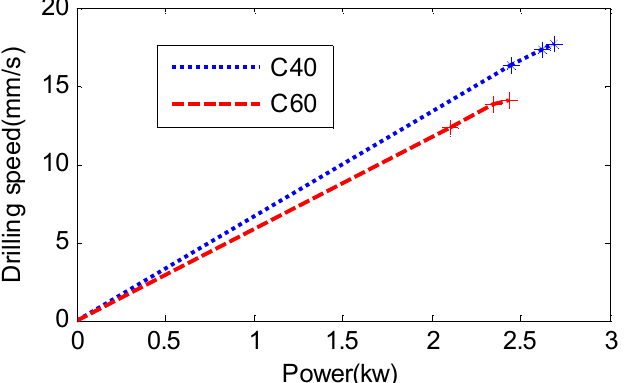
Figure 17. Curve of the power, and drilling rate, of the pneumatic